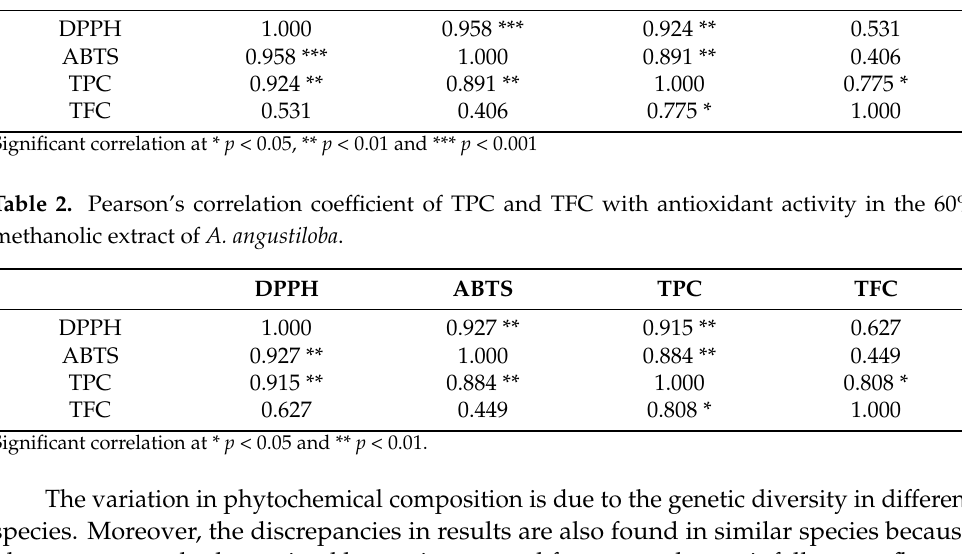
Table 1. Pearson’s correlation coefficient of TPC and TFC with antioxidant activity in the aqueous extract of A. angustiloba .